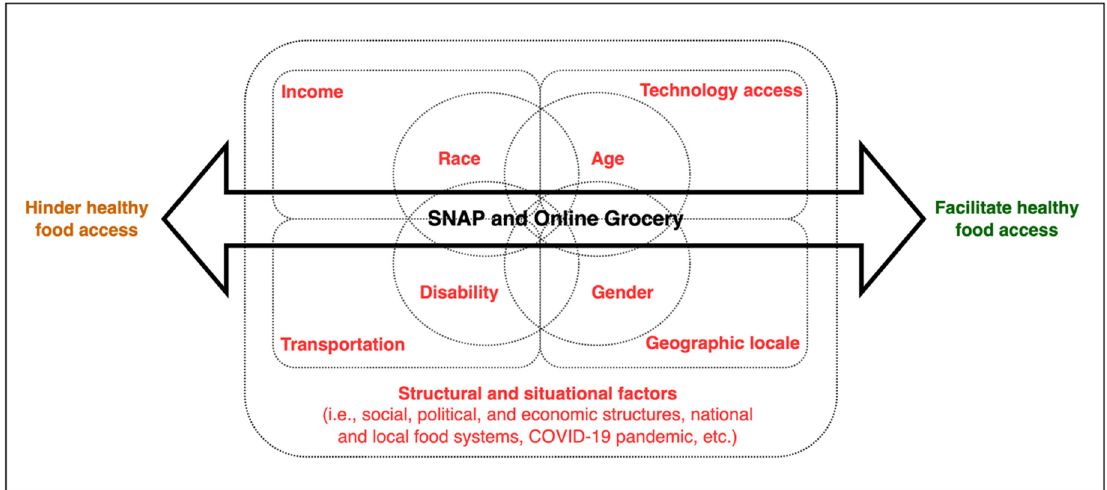
Figure 1. Conceptual framework depicting relationships between the perceived causes of inequities in healthy food access (rectangles), the most affected groups (circles), and the double-edged effect of SNAP and online grocery services supporting or hindering equity (two-sided arrow).